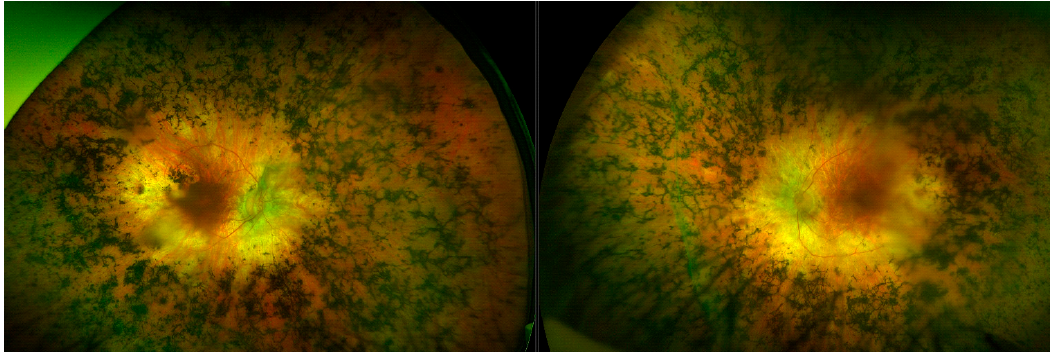
Figure 10. Montage of wide-field fundus images from a retinitis pigmentosa patient with a FLVCR1 genotype. The FLVCR1 genotype results in a phenotype (left- right eye, right- left eye) that appears to